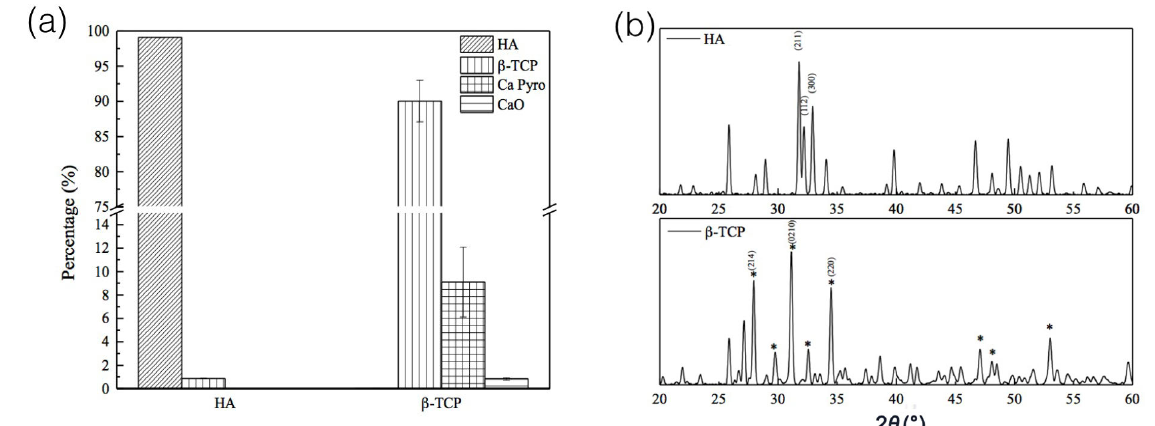
Fig. 3 (a) Percentage of each phase of the as-received raw materials prior to calcination (β-TCP vertical filled bars, calcium pyrophosphate (Ca Pyro) in hatched bars, and calcium oxide represented in horizontal filled bars). (b) The XRD spectra are a comparison between the two basic components of the ink. The upper box represents the XRD spectrum of hydroxyapatite (HA) group while the lower box represents the β-TCP group. A few of the most intense diffraction peaks are shown.